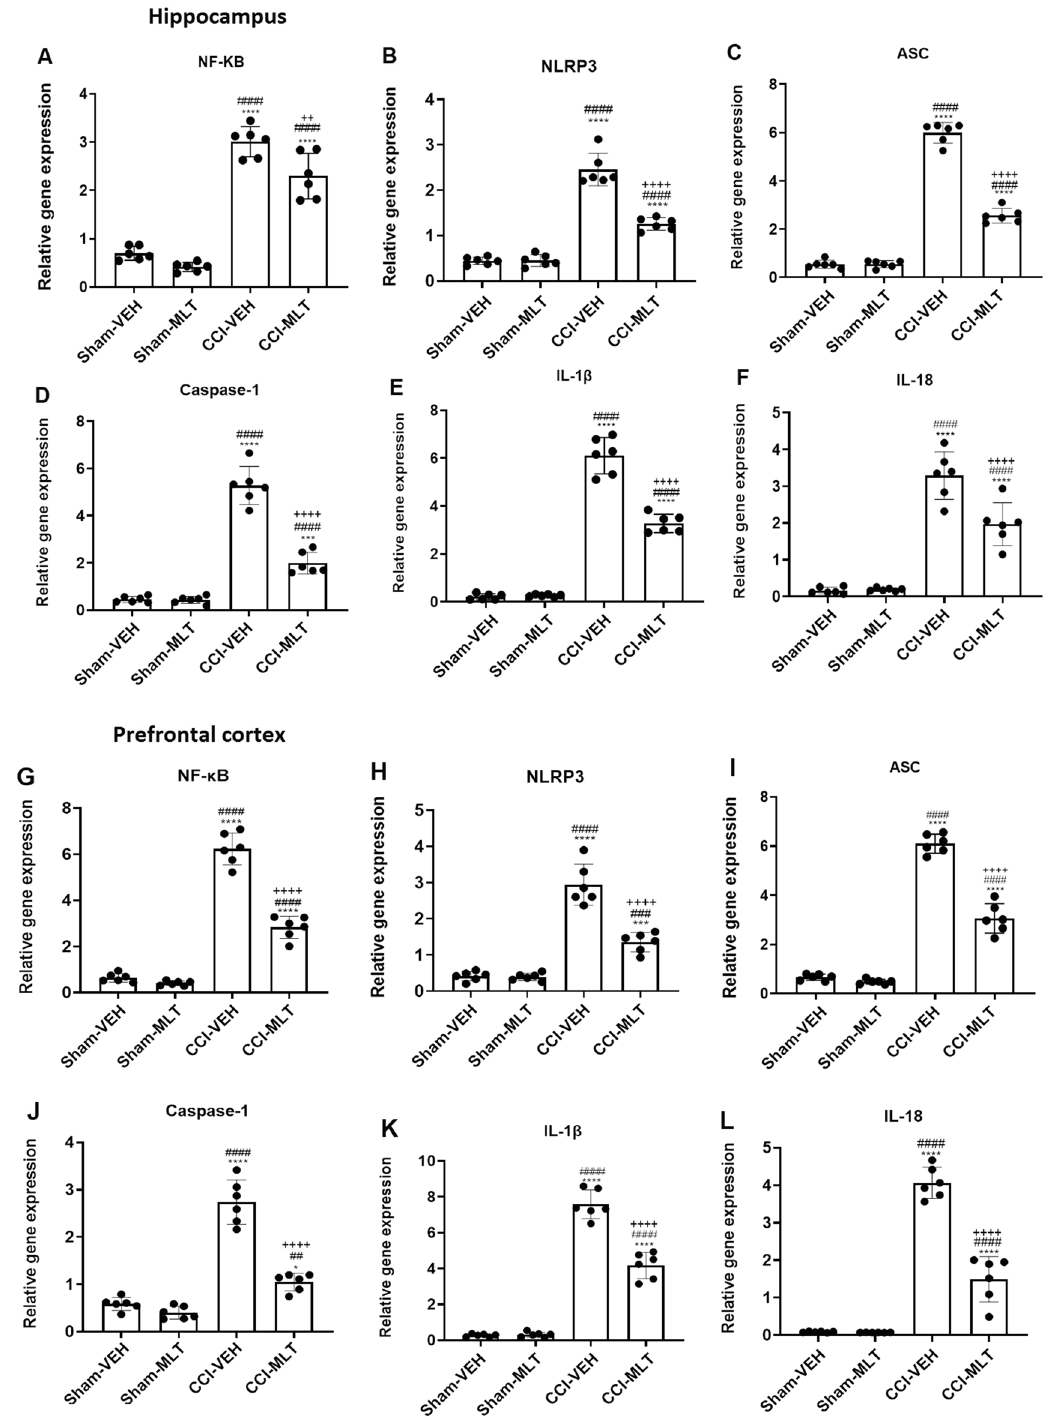
Figure 2. Effects of melatonin (MLT) on the gene expression of ( A,G ) nuclear factor-κB, ( B,H ) NLRP3, ( C,I ) ASC, ( D,J ) Caspase-1, ( E,K ) IL-1β and ( F,L ) IL-18 in the hippocampus and prefrontal cortex of chronic constriction injury (CCI)-induced rats. * P < 0.05, *** P < 0.001, and **** P < 0.0001 compared with the Sham- VEH group; ## P < 0.01, ### P < 0.001 , and #### P < 0.0001 compared with the Sham-MLT group, ++ P < 0.01 and ++++ P < 0.0001 compared with the CCI-VEH group. Sham-VEH: sham-operated animals, Sham-MLT: sham- operated animals MLT (10 mg/kg), CCI-VEH: pain-induced animals, and CCI-MLT: pain-induced animals received MLT (10 mg/kg), mean ± standard deviation, n = 6 per